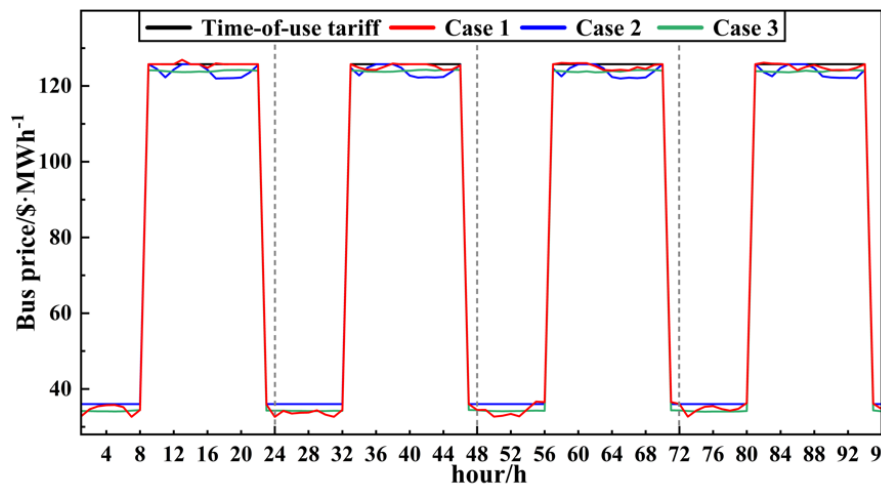
Figure 17. The bus prices of Bus 3 in three cases and the time-of-use tariff.